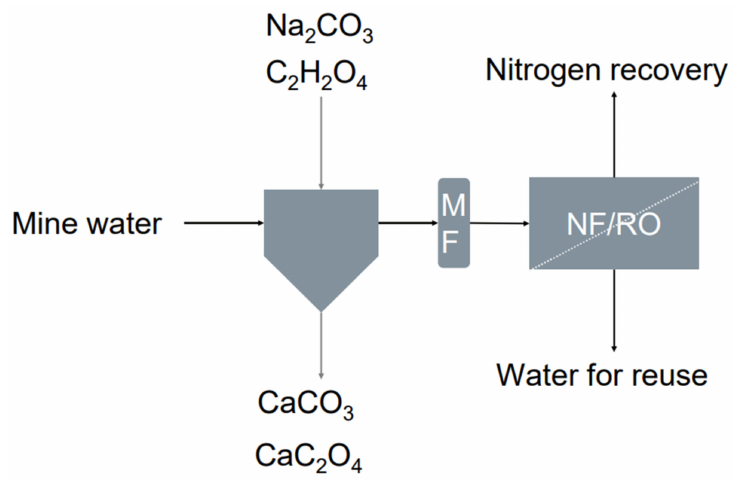
Figure 1. Studied process concept for nitrogen (N) concentration at a gold mine. Calcium (Ca) removal prior to nanofiltration (NF) or reverse osmosis (RO) was carried out using sodium carbonate (Na 2 CO 3 ) and oxalic acid (C 2 H 2 O 4 ). Ca was precipitated as calcium carbonate (CaCO 3 ) and calcium oxalate (CaC 2 O 4 ) and precipitates were removed by clarification and microfiltration